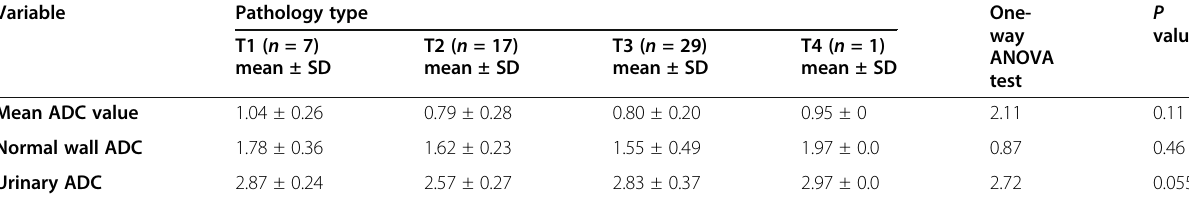
Table 3 Relation between pathology stage and ADC values Variable